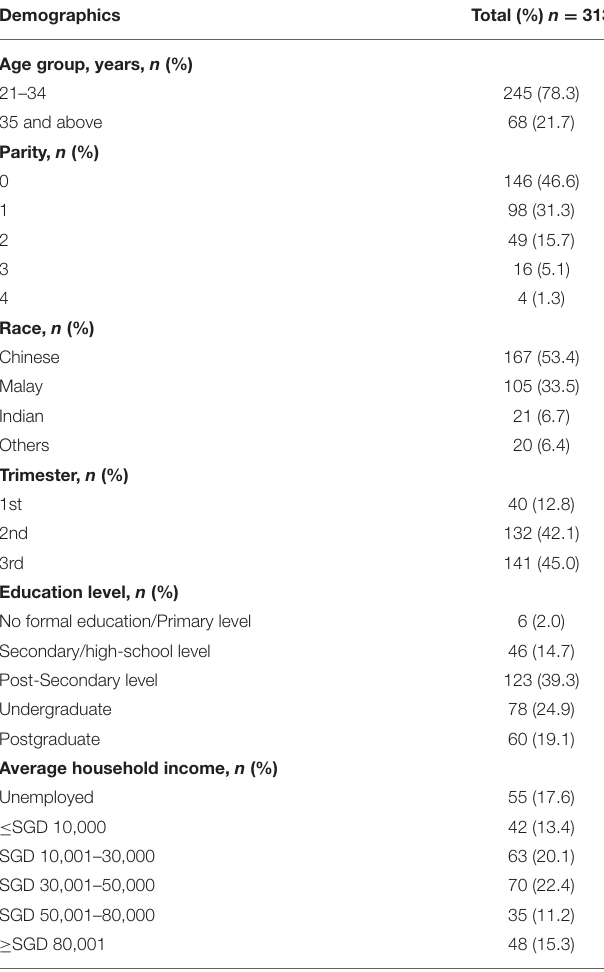
TABLE 1 | Clinical characteristics of survey participants. TABLE 2 | Knowledge and understanding of perinatal and neonatal care during the current COVID-19 pandemic.